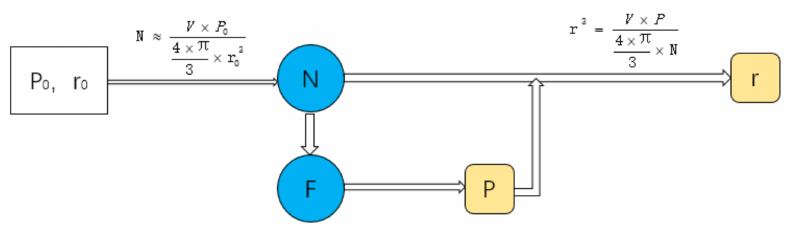
Figure 20. The relationship of the parameters after